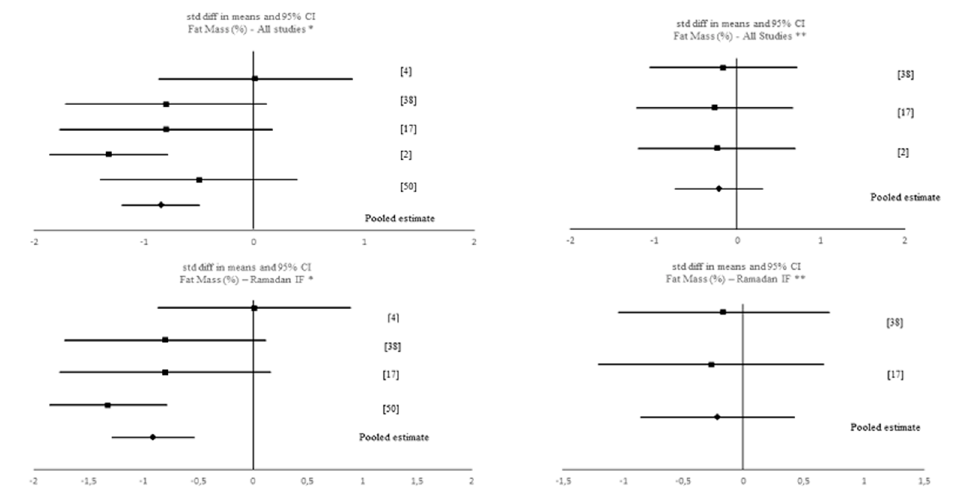
Figure 6. Forest plot of the effects from a fixed-effects meta-analysis shown as standardized mean difference with 95% confidence intervals on relative fat mass for all studies and for only Ramadan IF studies. For each study, the square represents the standardized mean difference between pre- and post-intervention time points and, whenever possible, between pre-post data of both intervention and control groups with the horizontal line intersecting it as the lower and upper limits of the 95% confidence interval. The rhombi represents the pooled estimated standardized mean difference. Note. * Pre-post tests, IF intervention; ** Pre-post tests, IF intervention vs. control.